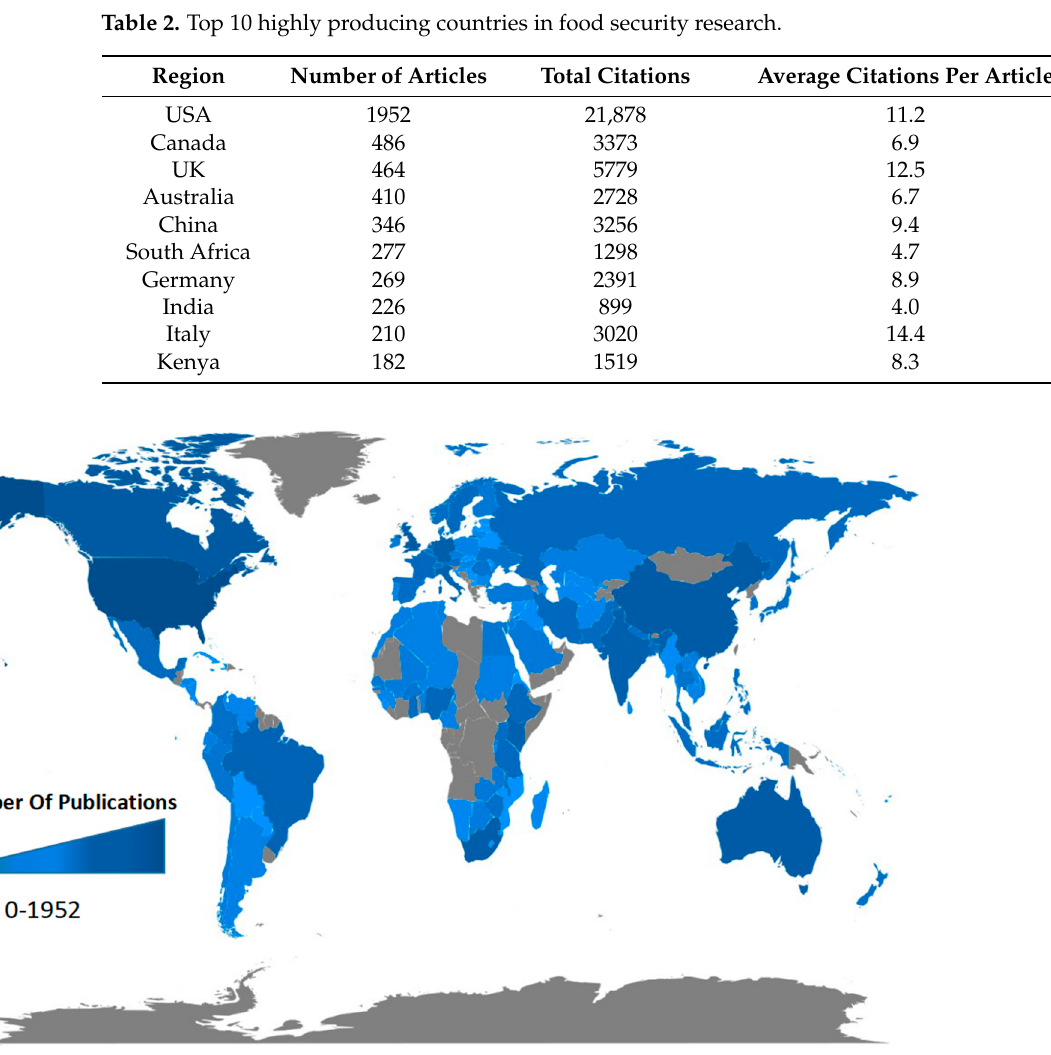
Figure 4. Country-based scientific production in the field of food security.